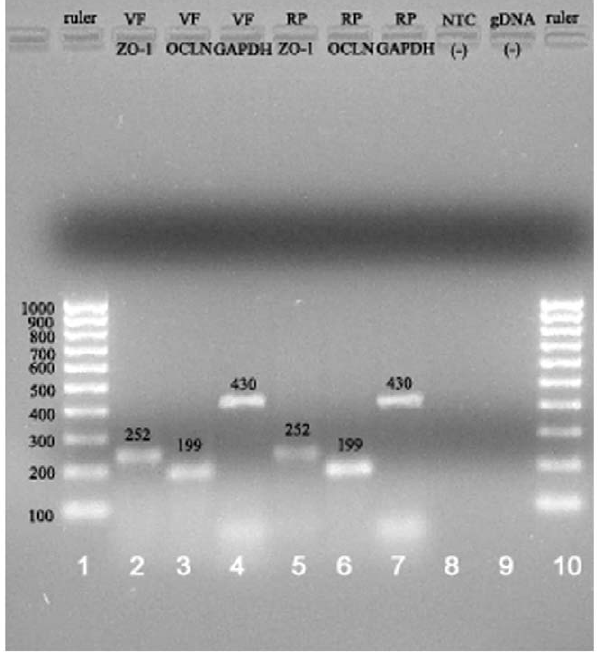
Figure 1. Electrophoresis results of occludin, ZO-1, and GAPDH mRNA in the native ovine vocal fold epithelium and ovine renal pyramids. Equal volumes (4 m l) of RT-PCR products from each sample were separated by electrophoresis on a 1.5% agarose gel and stained with ethidium bromide. Lane 1 and 10 show EZ load 100 bp molecular ladder (5 m l) increasing in size by 100 bp. Single PCR product of 252 bp with ZO-1-specific primers is detected in native vocal fold epithelium and renal pyramid (lane 2 and 5). Single PCR product of 199 bp with occludin-specific primers is also observed in both tissue groups (lane 3 and 6). GAPDH-specific primers extract PCR products of 430 bp with similar intensity from both tissue samples (lane 4 and 7). NTC and gDNA contamination controls do not bear any visible dsDNA band (lane 8 and 9).